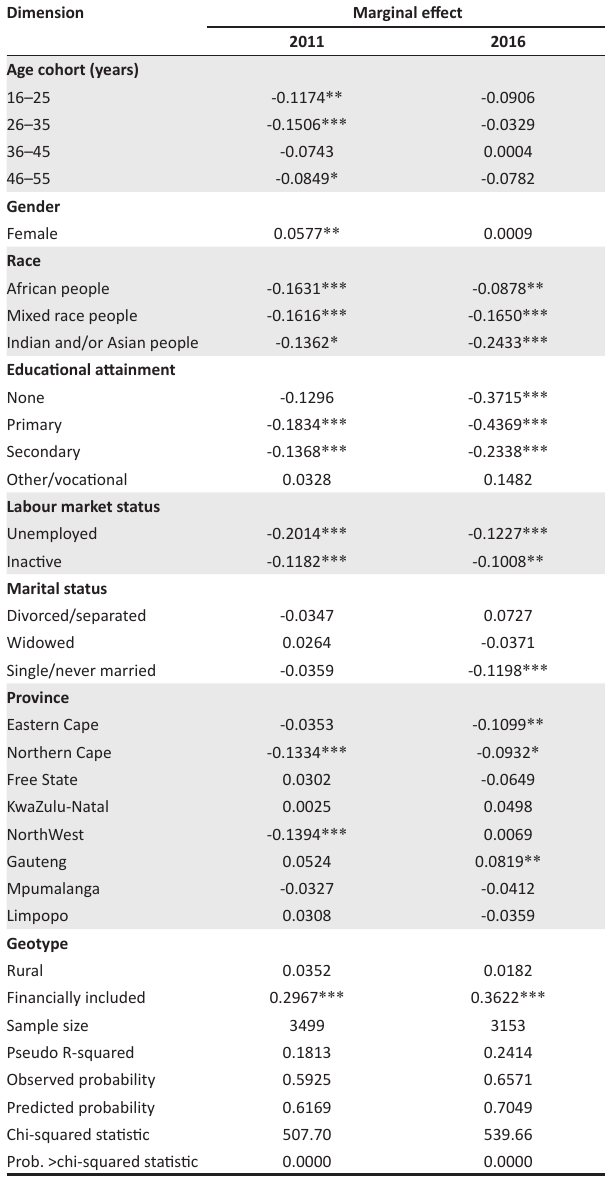
TABLE 6: Bivariate probit regressions on good financial health and financial inclusion likelihoods.